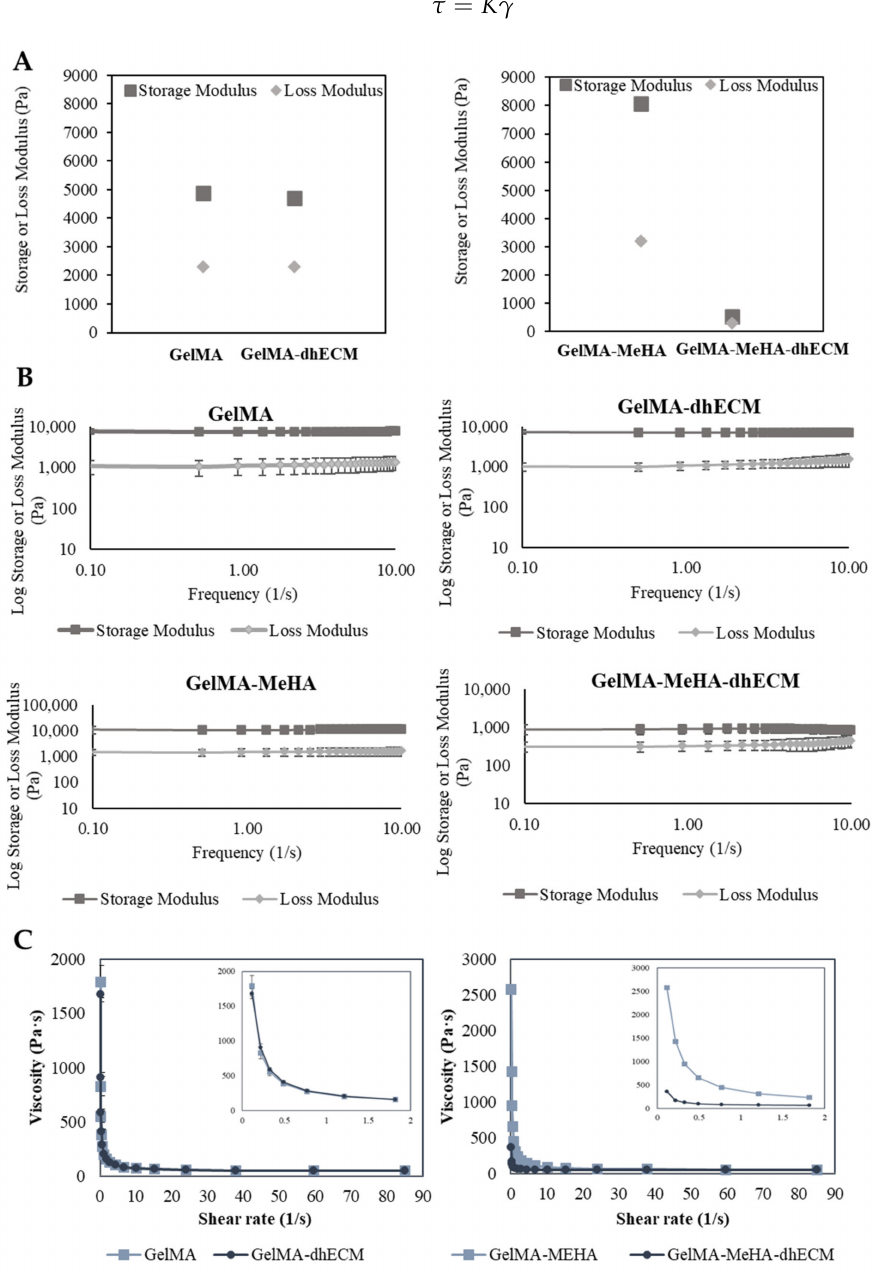
Figure 3. Viscoelastic properties of GelMA, GelMA–dhECM, GelMA–MeHA, GelMA–MeHA– dhECM hydrogels. ( A ) Storage and lost modulus values at a constant frequency of 1 Hz and a strain of 3%, ( B ) Change of storage and loss modulus with respect to frequency at a strain of 2%, ( C ) Plots of viscosity vs. shear rate, inset panels showing the change of viscosity with a smaller shear rate change ( n ≥